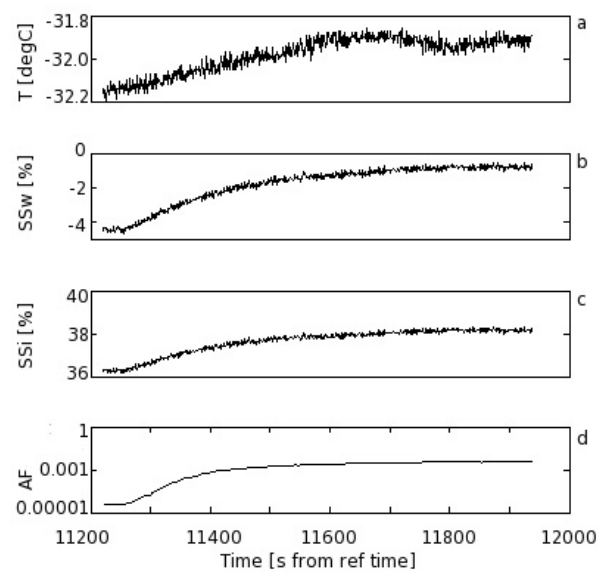
Fig. 7. A typical SS-scan, performed for ATD sample. (a) Sample temperature time series, (b) SSw time series, (c) SSi time series, (d) Number of particles > 3µm versus time for the SS-scan.